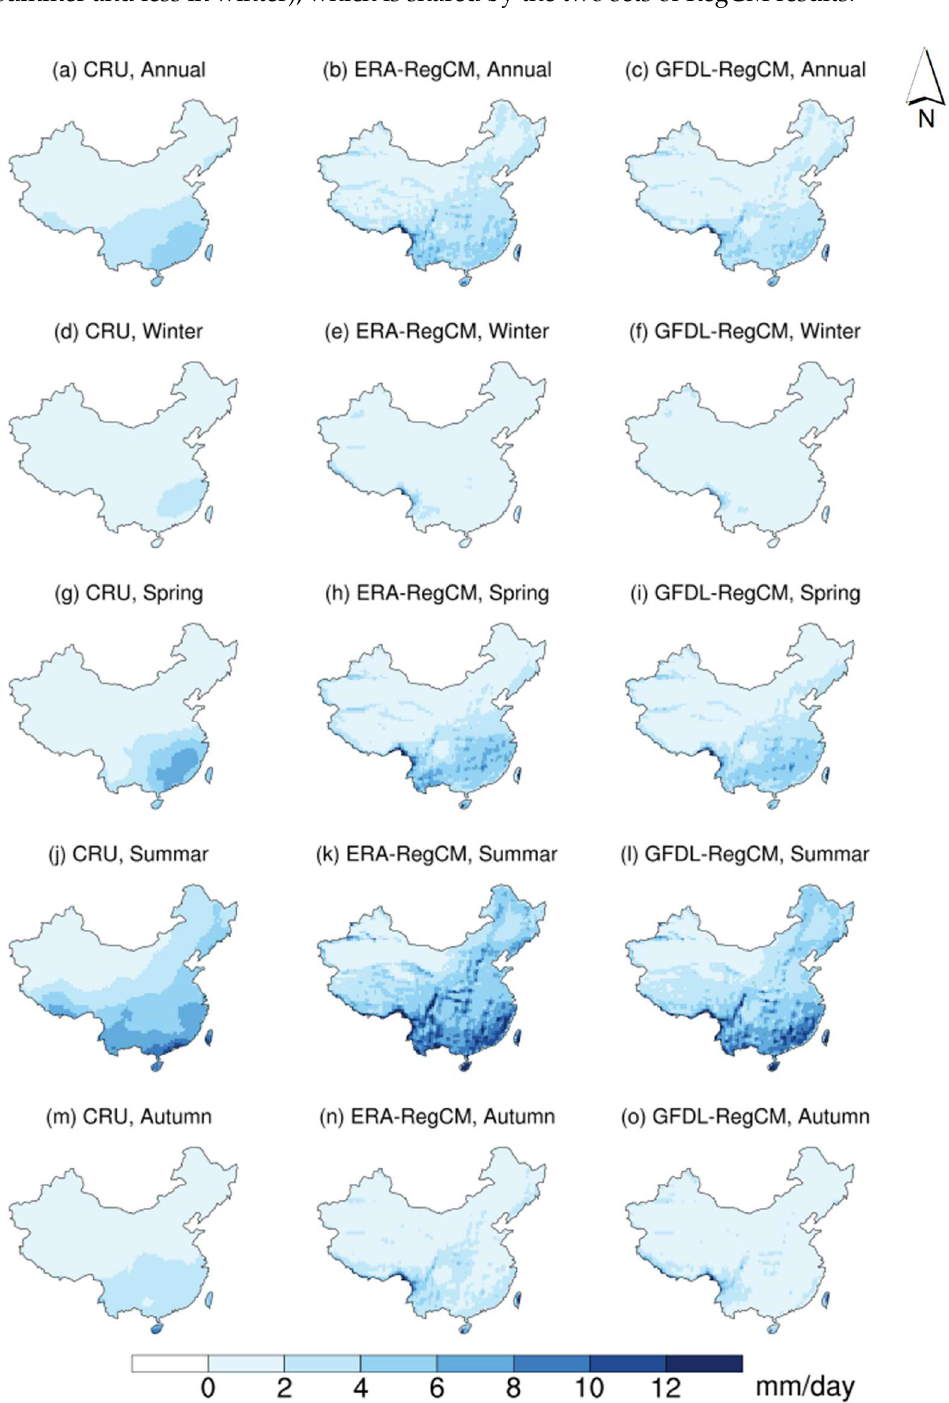
Figure 2. Observed and RegCM-simulated precipitation over China. The annual and seasonal averages are calculated with respect to the baseline period of 1986 to 2005. The spatial pattern of actual evapotranspiration from MODIS and GLEAM (Figure 3a,d) shows more regional details than the observed precipitation pattern from CRU, which is in part due to the higher resolution of remote sensing data than that of the grid-